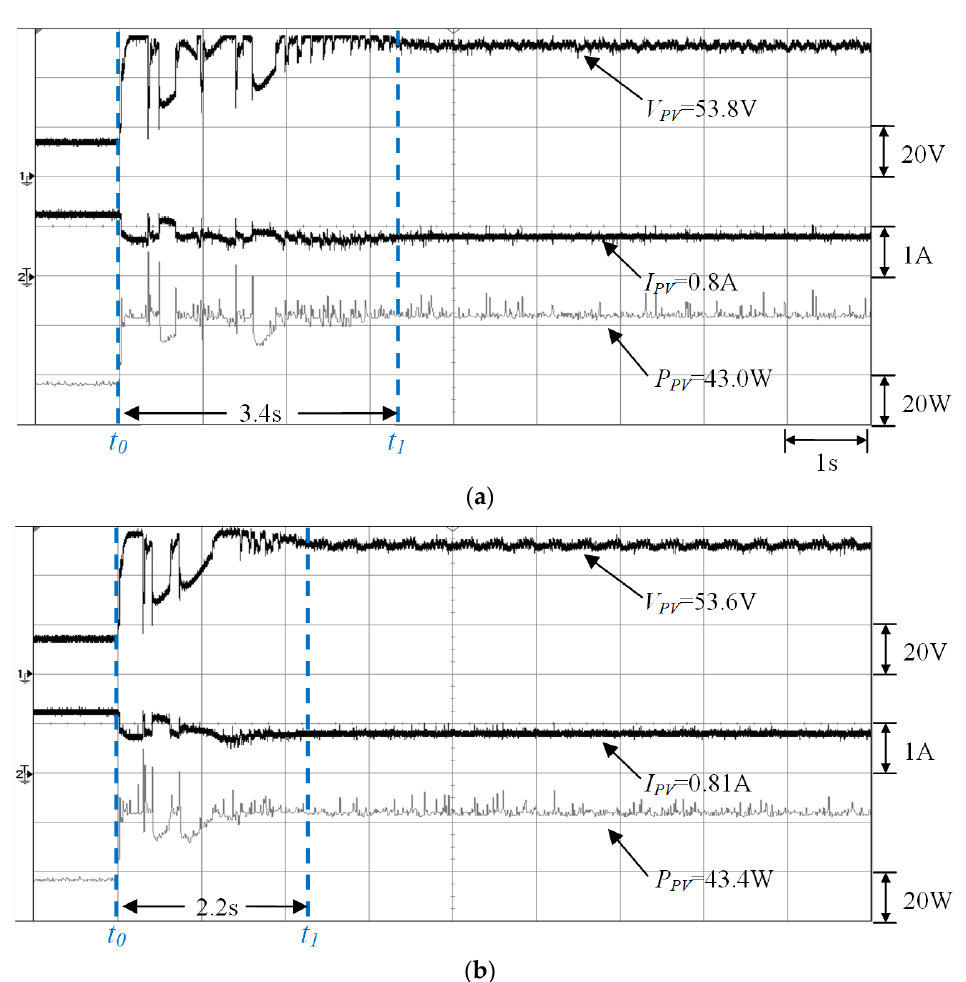
Figure 15. Results of the four-serial and one-parallel module array (0%, 30%, 50%, and 70% shading) measured by using ( a ) conventional TLBO ( P mp = 43.0 W) and ( b ) the proposed I-TLBO ( P mp = 43.4 W).